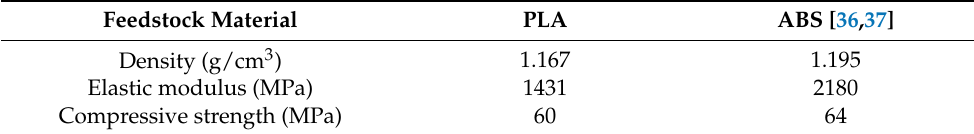
Table 2. Mechanical properties of PLA and